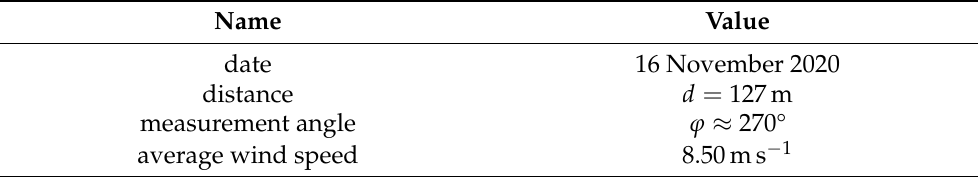
Table 3. Measurement conditions for vertical alignment. See Figures 1a and 6 for sketches of the experimental setup.